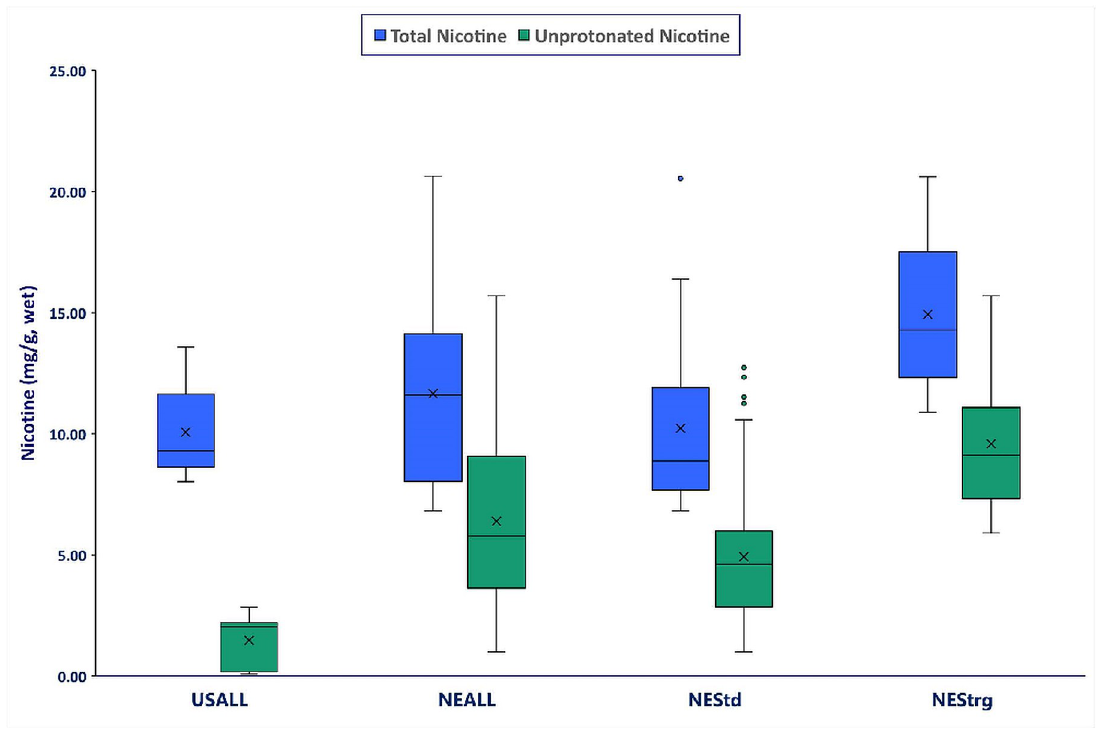
Fig 1. Total and unprotonated nicotine concentrations (mg/g, wet weight) for all US snus (USALL), all Northern Europe snus (NEALL), all NE snus with “standard” descriptors (NEStd) and all NE snus with “strong” descriptors (NEStrg). Note: USALL (n = 8: all 8 portion); NEALL (n = 56: 7 loose and 49 portion); NEStd. (n = 39: 6 loose and 33 portion); NEStrg (n = 17: 1 loose and 16